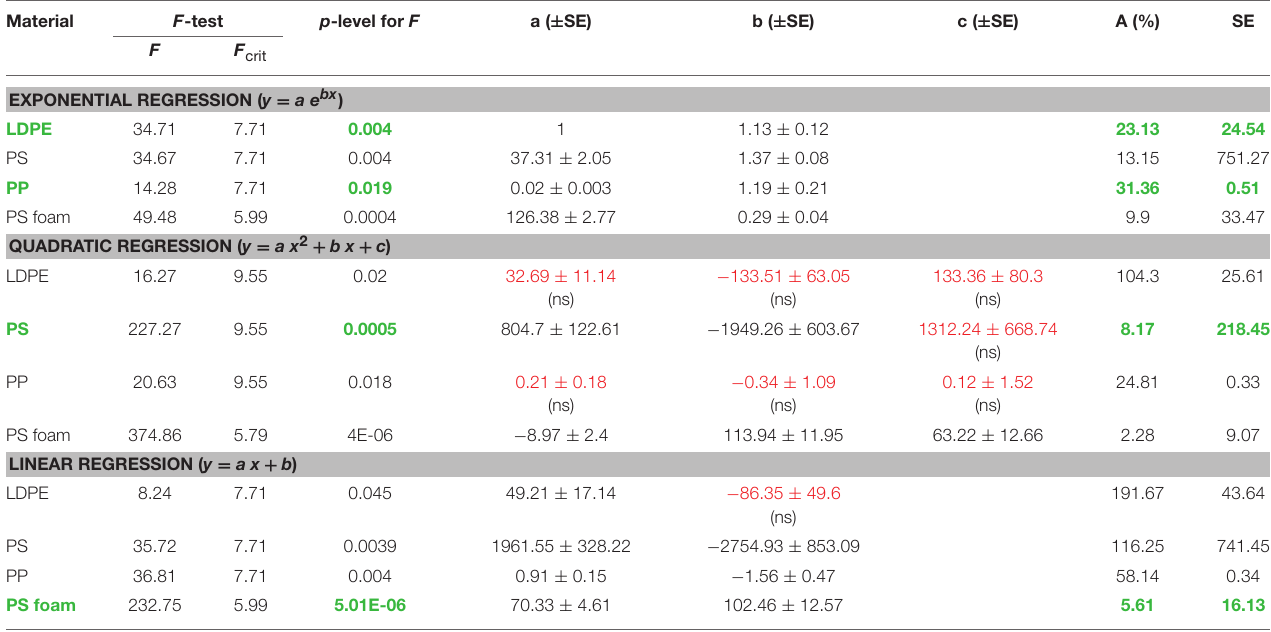
TABLE 4 | Results of statistical analysis of exponential, quadratic, and linear models for relationship between the number of MPs particles and dimensionless time of degradation experiment.